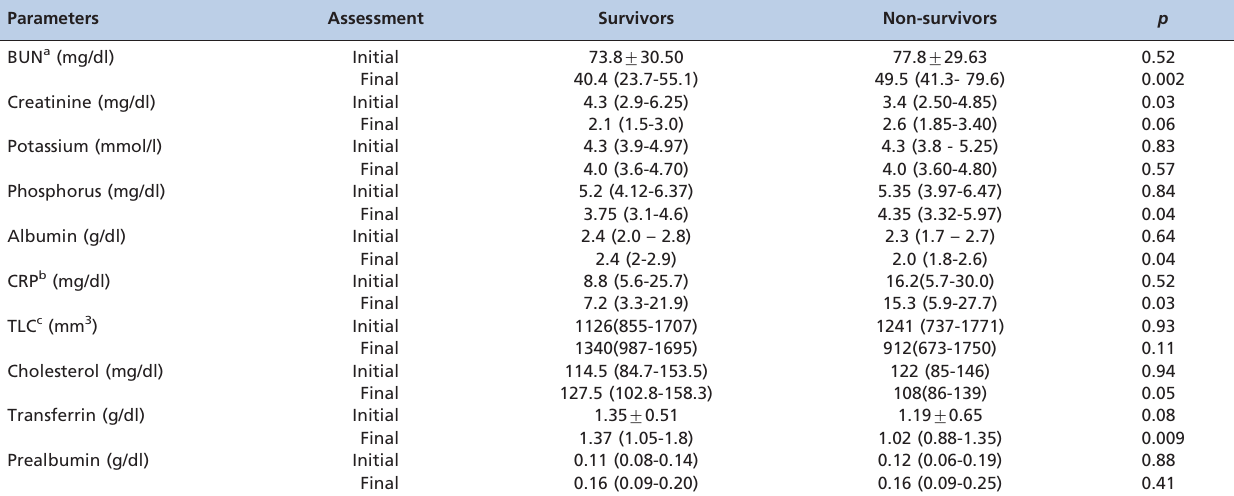
Table 2 - Laboratory parameters at the initial and final assessments in the survivors and non-survivors. Parameters